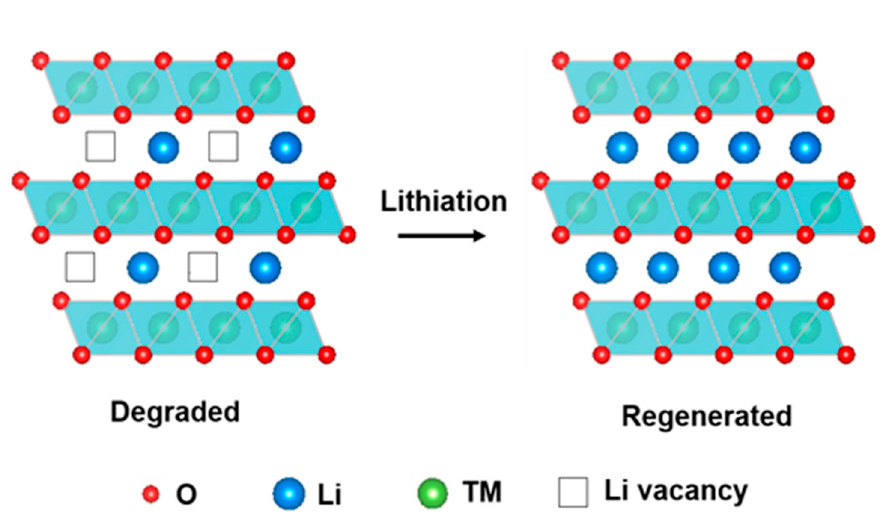
Figure 11. Relithiation of degraded cathode material.